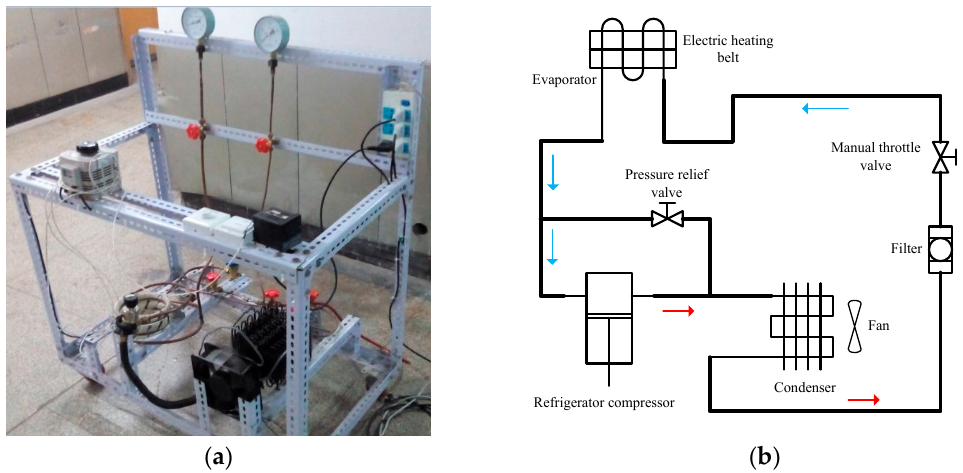
Figure 1. Test facility for refrigeration system: ( a ) The Laboratory Furniture; ( b ) The experimental system schematic figure.